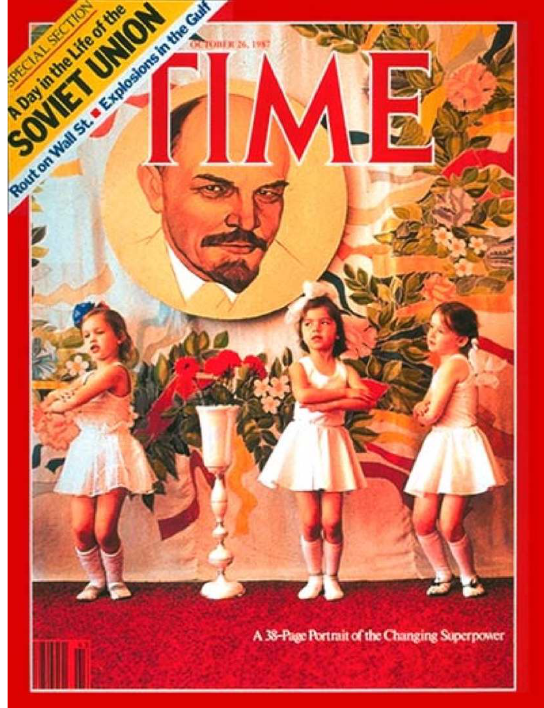
Figure 4. Cover of Time magazine, 26 October 1987, Vol. 130, No.